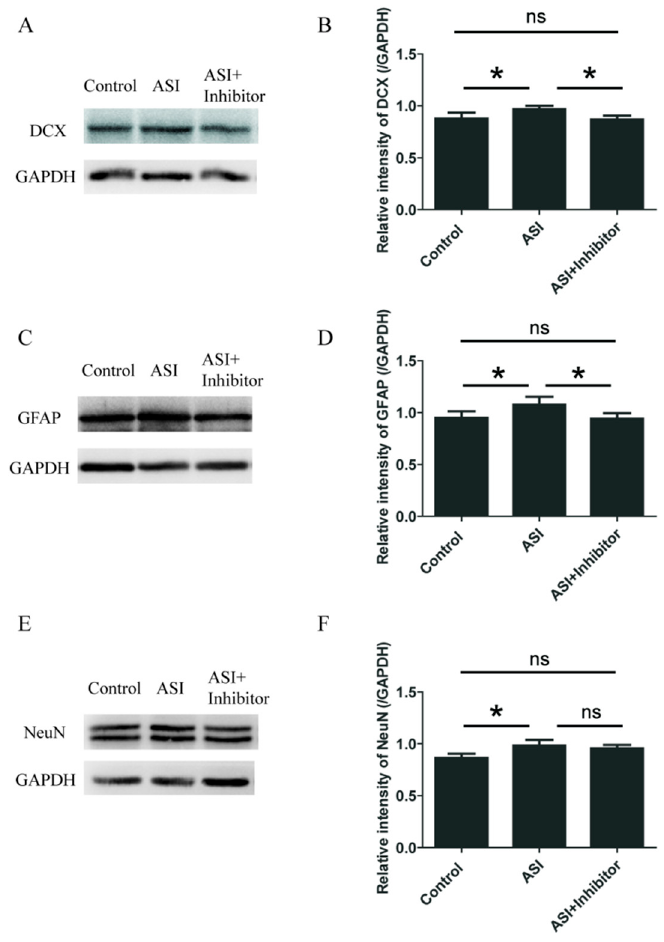
Figure 7. CXCR2 inhibitor abrogated the effects of ASI (25 mg/kg) on proliferative cells of adult neurogenesis and newly generated neurons. ( A , C , E ) CXCR2 inhibitor abolished the effect of ASI on DCX, GFAP and NeuN in the hippocampus of mice. ( B , D , F ) Gray intensity analysis of DCX, GFAP and NeuN in the hippocampus of mice ( n = 5/group). * p < 0.05. The data are presented as mean ± SD.